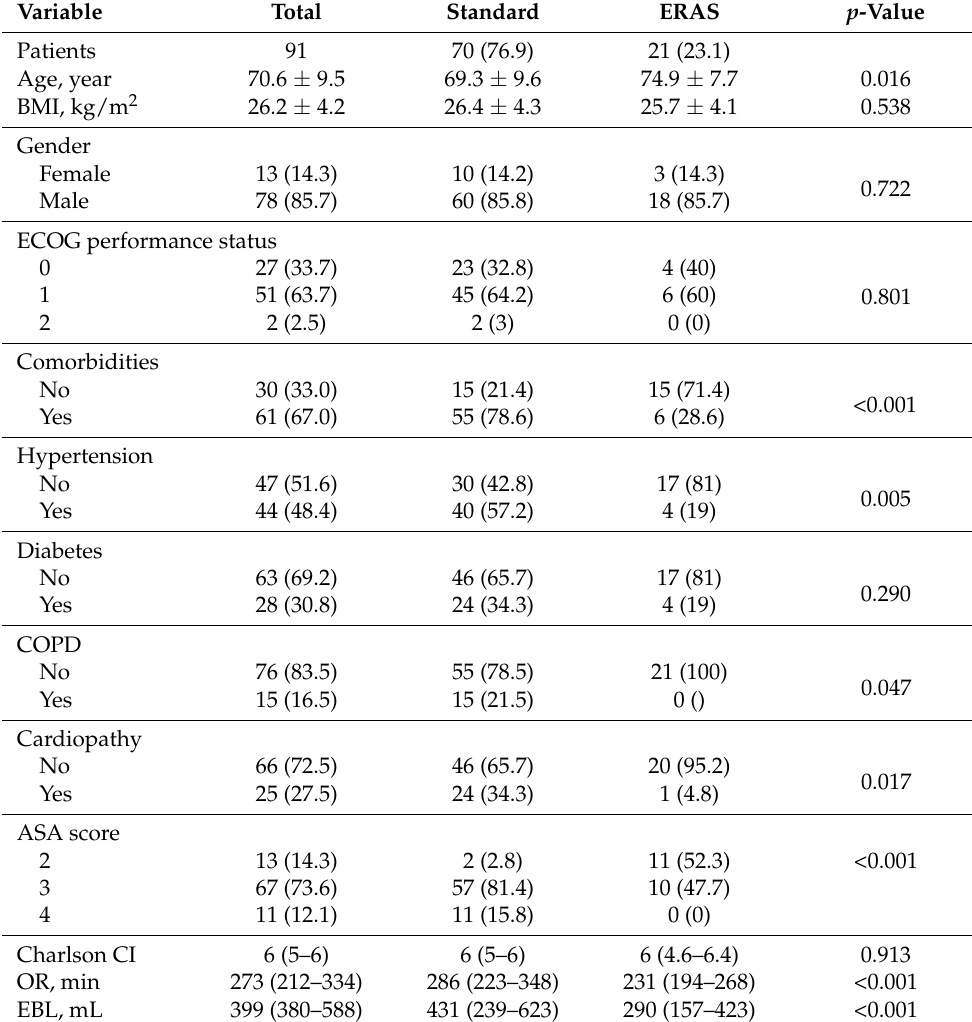
Table 2. The patient characteristics.